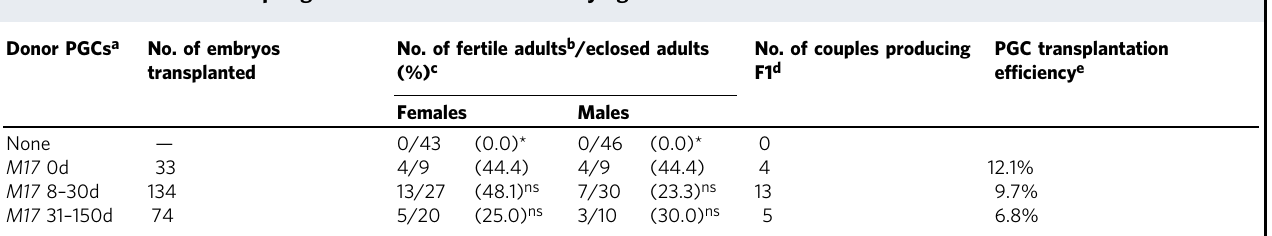
Table 2 Production of offspring derived from donor PGCs by agametic